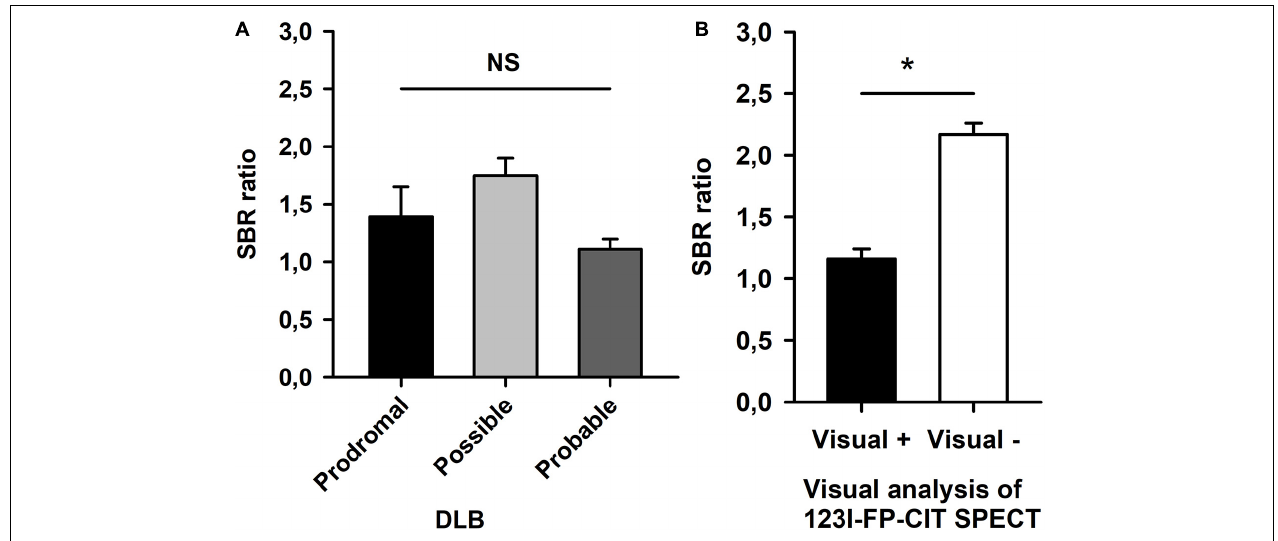
FIGURE 3 | Semiquantitative analysis of 123I-FP-CIT-SPECT. Striatum-to-background (SBR) ratios are shown of prodromal, possible, and probable DLB patients in (A) . (B) Demonstrates significant different SBR ratios between patients with vs. those without a nigrostriatal deficit by visual analysis of 123I-FP-CIT-SPECT. ANOVA: * p < 0.05, n.s.,